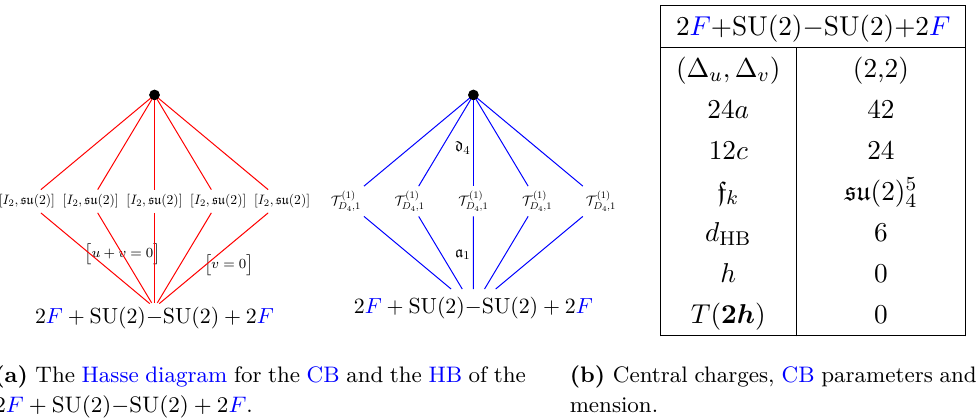
Figure 9. Information about the SU(2) N = 2 theory with two hypermultiplets in the ( 2 , 1 ) ⊕ ( 1 , 2 ) and one in the ( 2 , 2 )